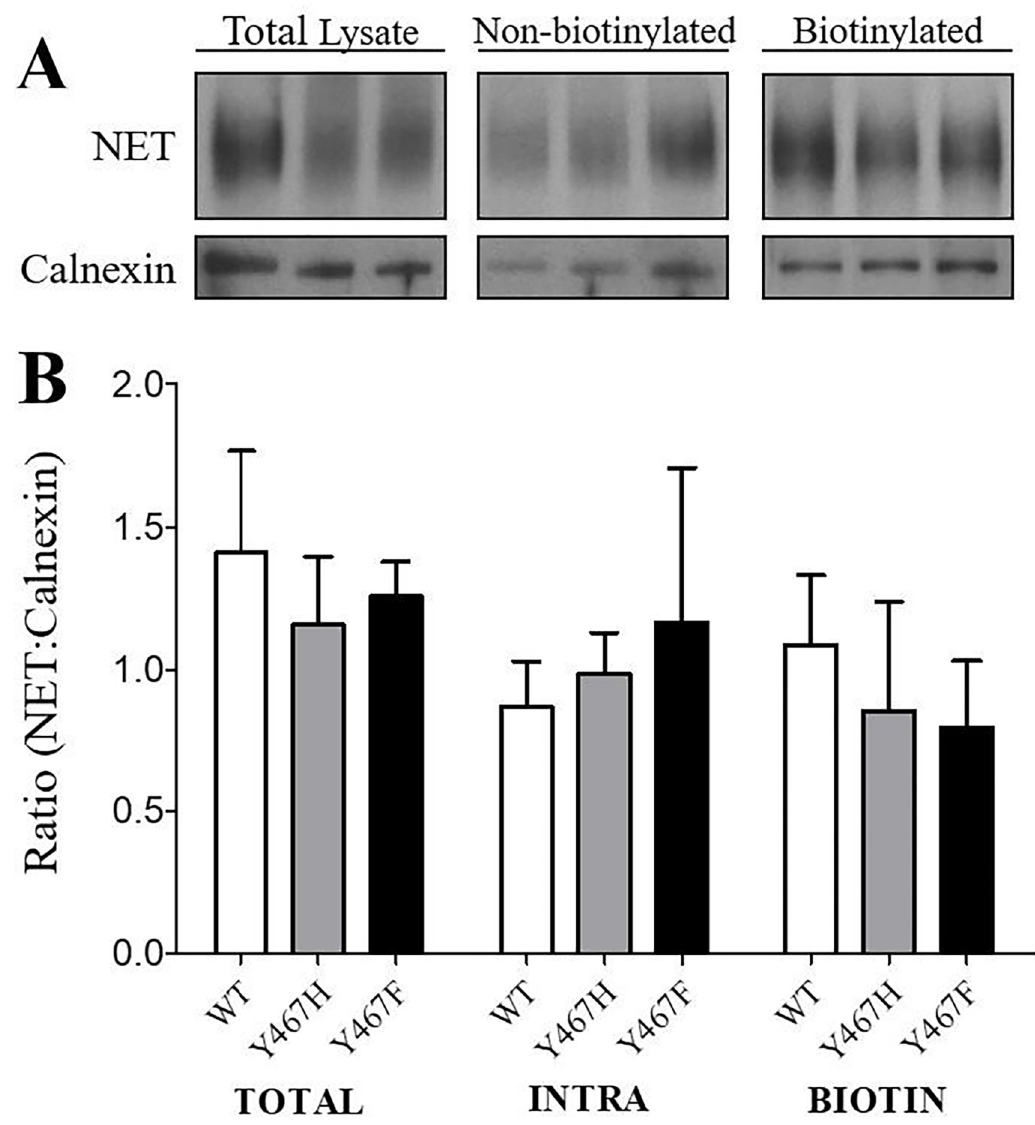
Fig 2. Cell surface expression of WThNET, Y467F, and Y467H was determined by biotinylation and Western blotting. (A) Representative immunoreactive blots for NET and calnexin (as control protein) in total, non-biotinylated (intracellular) and biotinylated (surface expression) fractions. (B) The quantification of total, non-biotinylated (INTRA) and biotinylated (BIOTIN) expression of NET was expressed as mean ± S.E.M of the ratio of total, non-biotinylated or biotinylated NET immunoreactivity to Calnexin immunoreactivity from 5 independent experiments. Raw immunoblots are provided in S1 File. (Table 3). Compared to WT hNET (DA, 174 ± 20 nM, cocaine, 4377 ± 904 nM), the apparent affinity (IC ) values for DA or cocaine inhibiting [ 3 H]DA uptake were not altered in Y467H 50 (DA, 236 ± 21 nM, Cocaine, 3920 ± 1010 nM), or Y467F (DA, 125 ± 12 nM, Cocaine, 4814 ± 964 nM). Compared to WT hNET (26.7 ± 4.0 nM), the IC for nisoxetine inhibiting 50 [ 3 H]DA uptake was significantly reduced in Y467H [15.9 ± 5.0 nM, t = 3.0; p < 0.05, (4) unpaired Student’s t test] but not altered in Y467F (21.1 ± 5.1 nM). Compared to WT hNET (NE, 775 ± 218, nisoxetine, 10.1 ± 2.3 nM, and cocaine, 6959 ± 2130 nM), the IC values for 50 NE, nisoxetine, and cocaine inhibiting [ 3 H]NE uptake were not altered in Y467H (NE,